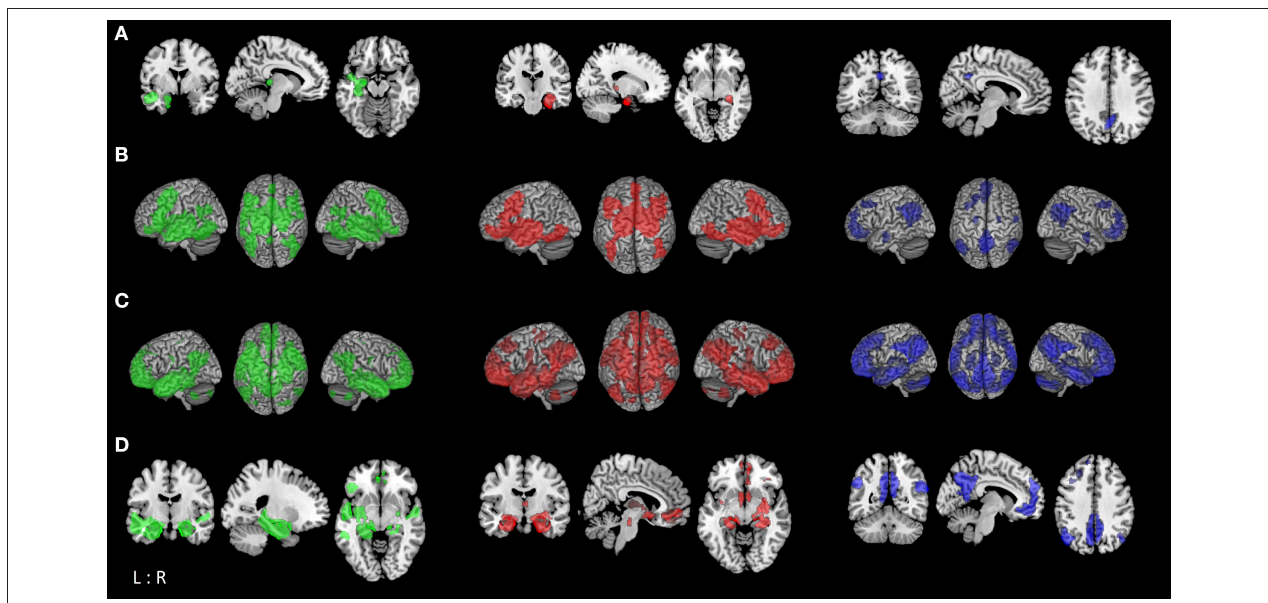
FIGURE 1 | Functional connectivity modeling of MCI-atrophy seeds. (A) Location of the seed regions ( left (green) : left temporal seed; middle (red) : right temporal seed; right (blue) : parietal seed [same color coding for (B–D) ]) showing convergent evidence of atrophy as revealed by coordinate-based meta-analysis across voxel-based morphometry studies in MCI ( 8). (B) Task-based brain-wide co-activation maps of the respective seed regions as revealed by meta-analytic connectivity modeling (MACM; cluster-level FWE corrected at p < 0.05, p < 0.001 at voxel-level). (C) Resting-state connectivity of respective seeds (FWE corrected at p < 0.05). (D) Conjunction between MACM and resting-state connectivity of respective seed regions using minimum statistic